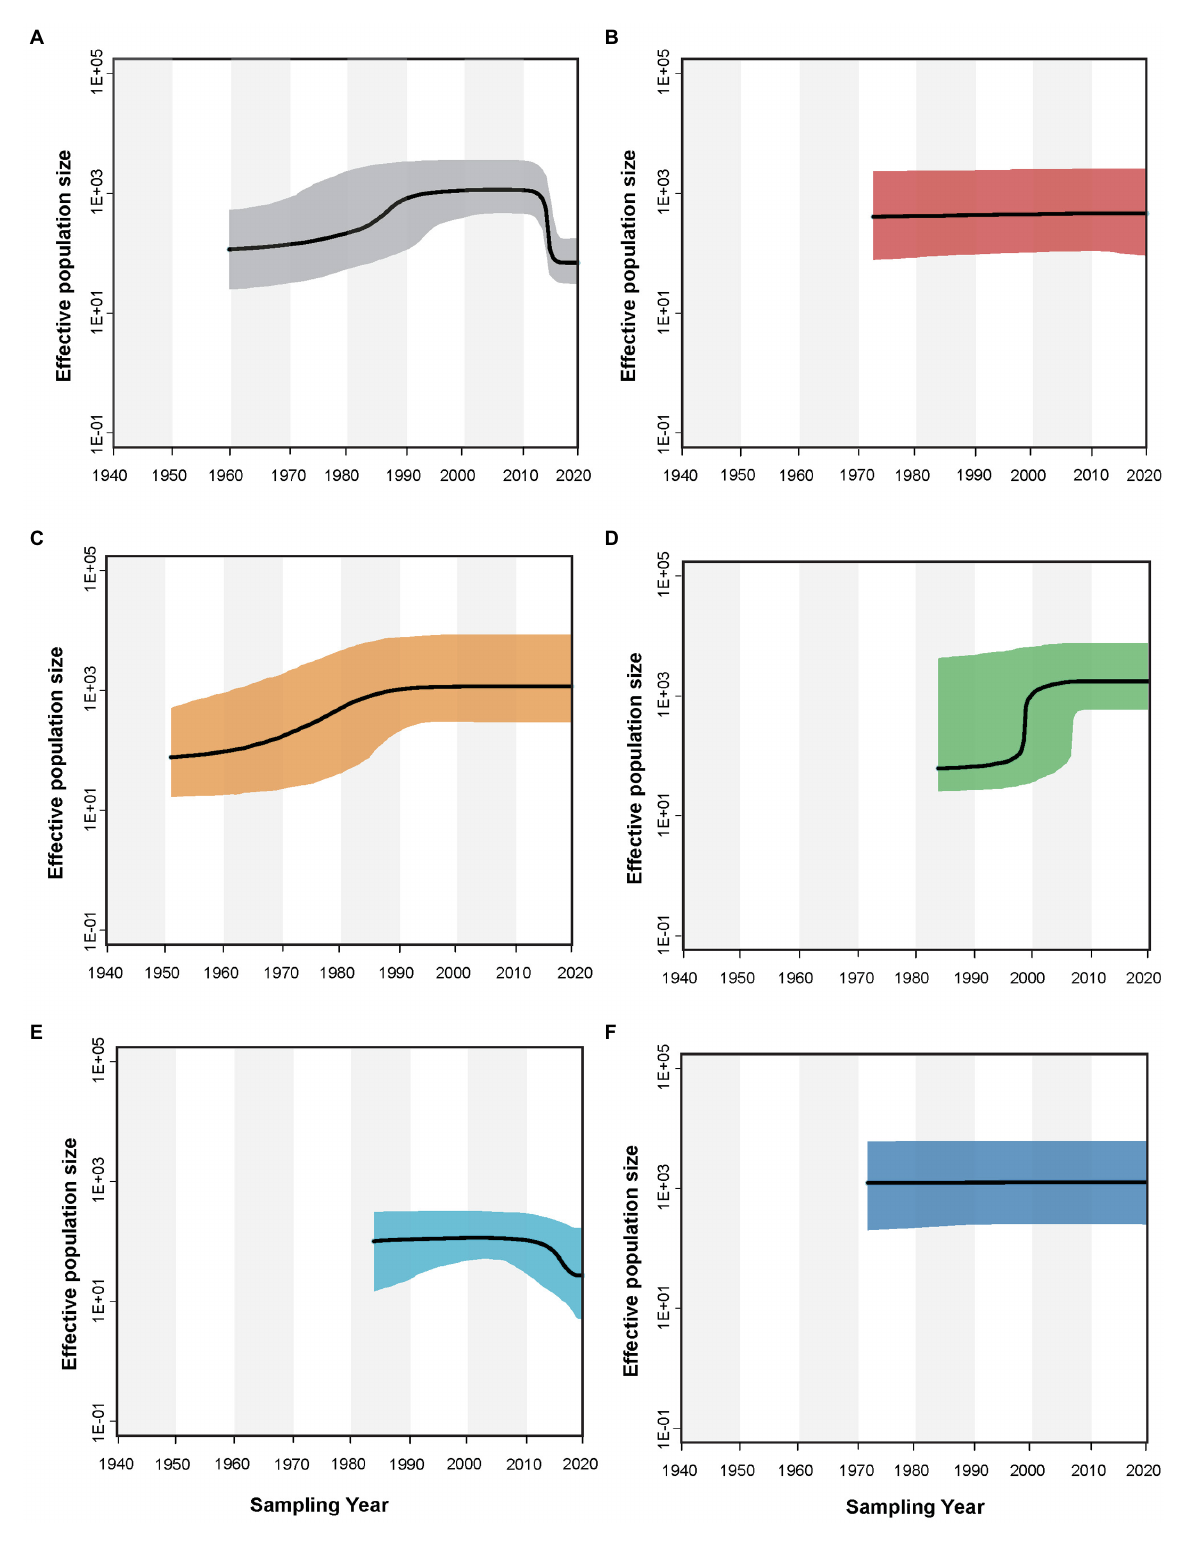
FIGURE 5 Bayesian skyline plot that describes the demographic history of alfalfa mosaic virus for (A) the global, (B) Asian, (C) European, (D) Middle Eastern, (E) North American, and (F) Oceanian AMV populations. The y -axis represents the population size (net) whereas the x -axis is given in years. The black lines show the median estimate of the population size, and the shaded areas show the 95% credibility